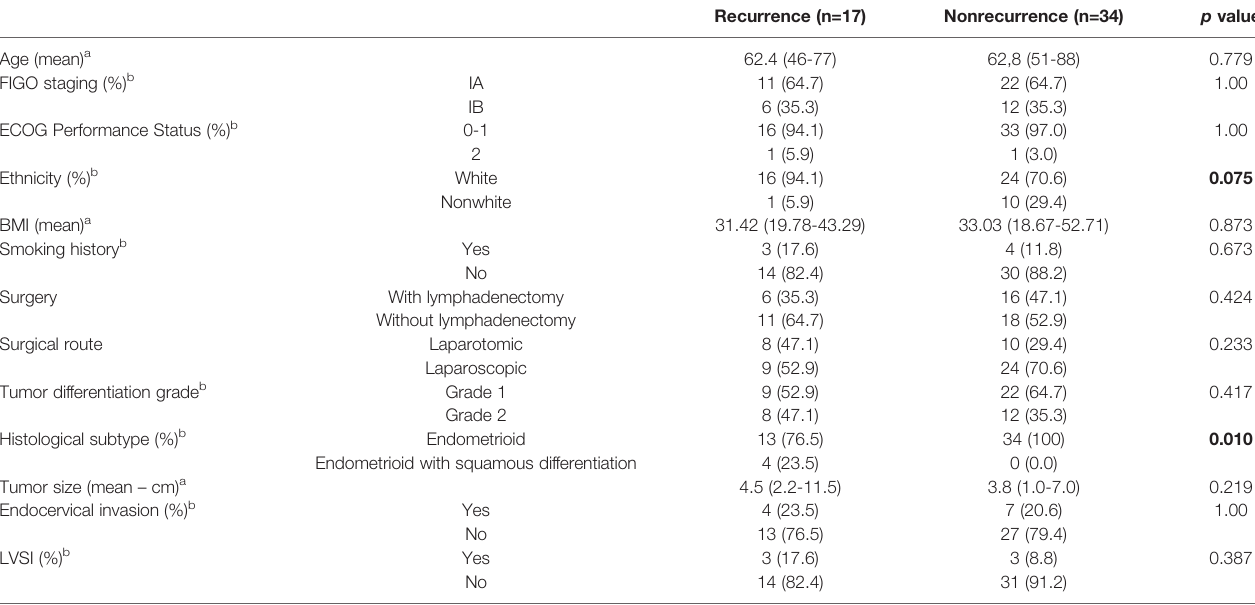
TABLE 1 | Clinical and pathological characteristics of patients with low- and intermediate-risk endometrial